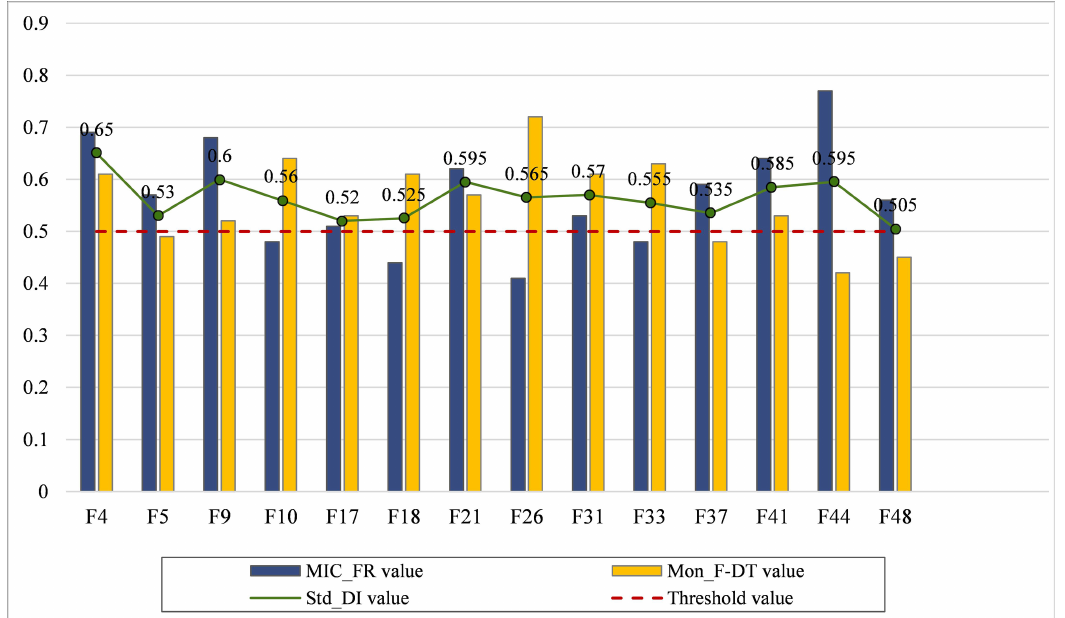
Figure 10. Features in the final optimal feature set Opt DI under working condition